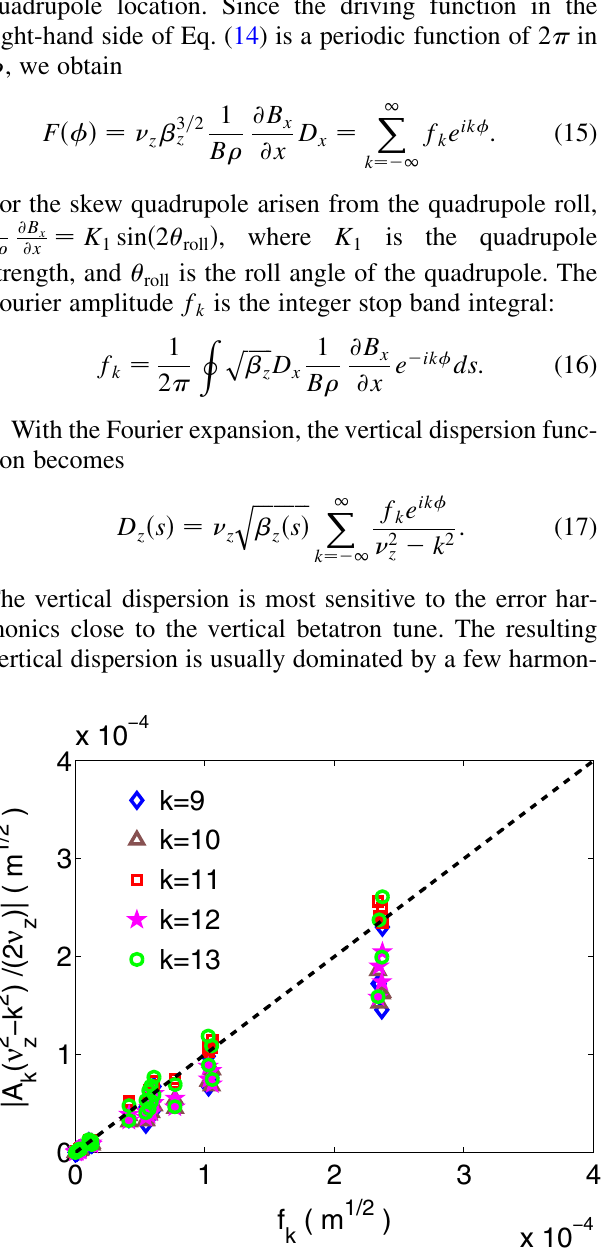
(cid:4) (cid:2) 2 (cid:1) k 2 (cid:5) =(cid:2) FIG. 5. (Color) Comparison of A , where A is the z k z k k th Fourier harmonics of the dispersion function, for the QBA- of Eq. (16). The vertical dispersion functions lattice [1], with f k are generated by 1 mrad quadrupole roll to different quadrupoles in the QBA-lattice.